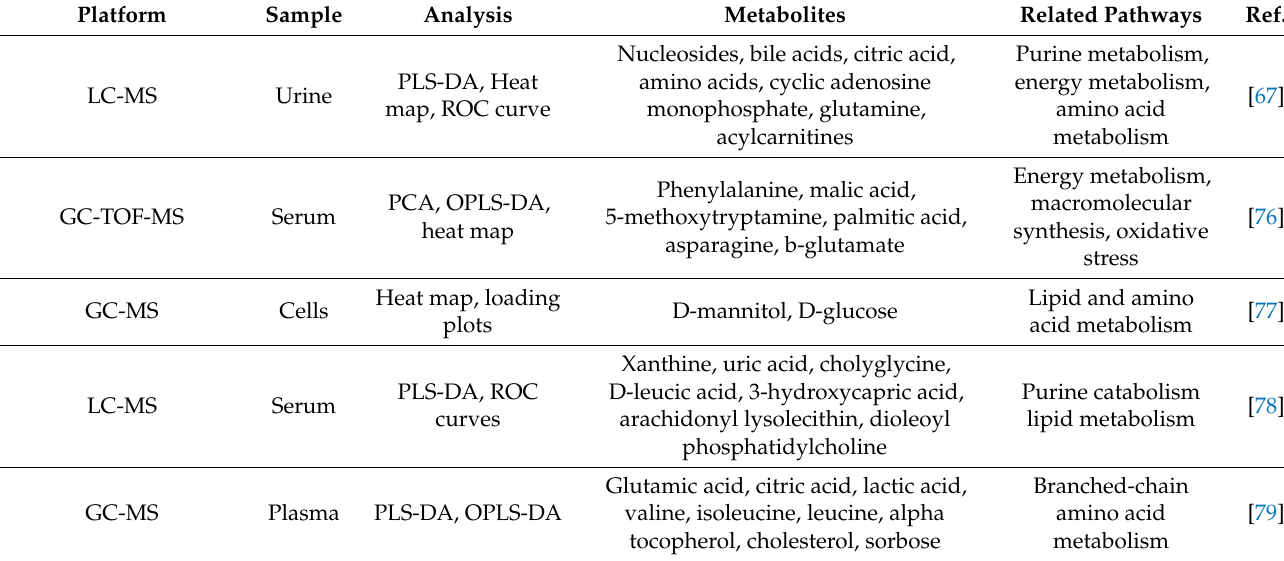
Table 4. Metabolome and metabolomics profiling in hepatocellular